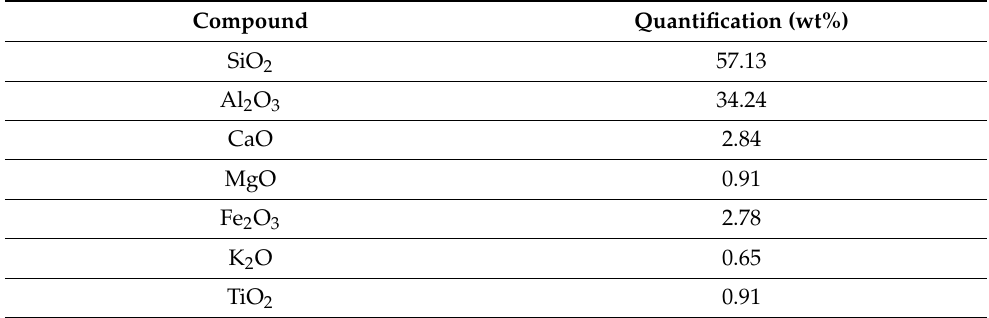
Table 1. Quantification of various compounds present in the fly